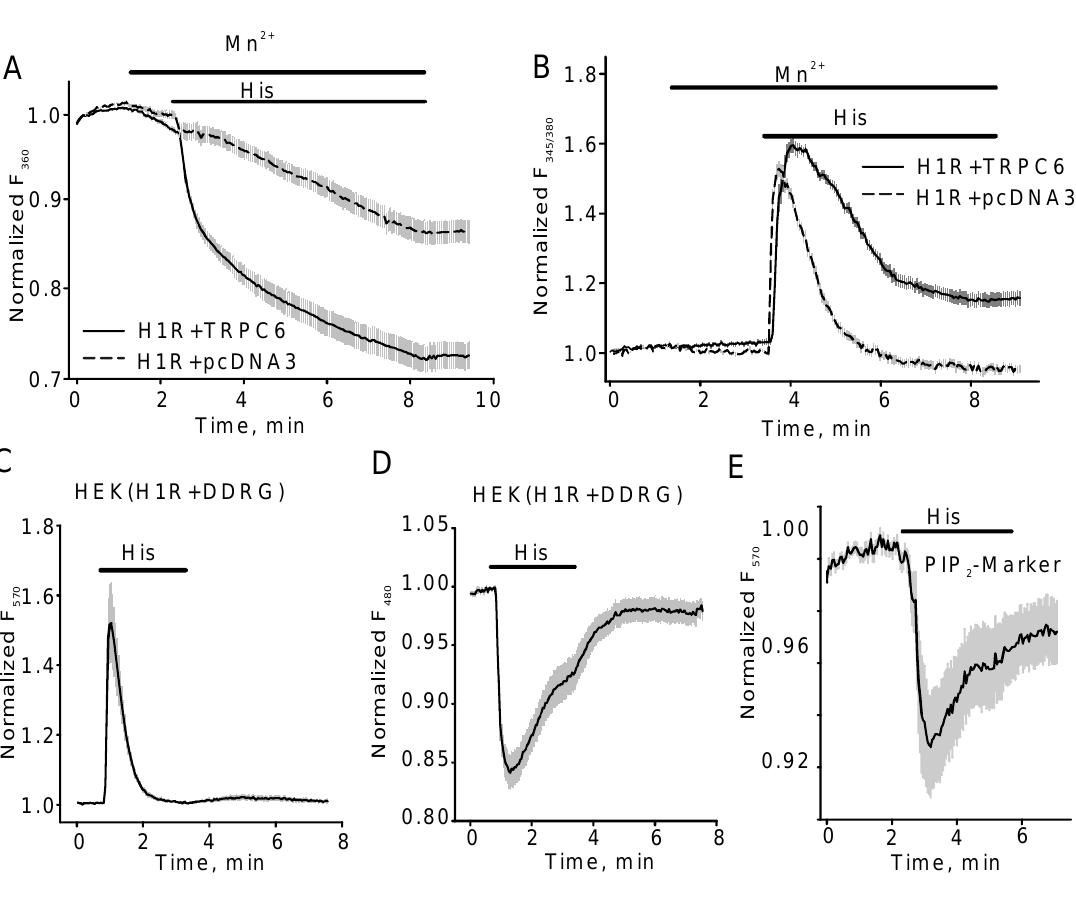
Figure 1. Histamine induces transient intracellular diacylglycerol (DAG), phosphatidylinositol diphosphate (PIP ) and Ca 2+ increases in histamine H1 receptor (H1R)- 2 expressing human embryonic kidney (HEK) cells. ( A , B ) The traces show fluorescence changes in HEK cells expressing H1R + pcDNA3 or H1R + TRPC6. Mn 2+ (0.5 mM) influx was determined in the control group and cells expressing TRPC6 channel using the Mn 2+ quench approach. Fura-2 fluorescence was excited at 360 nm and the percent of fura-2 fluorescence decrease was shown in ( A ). ( B ) shows fluorescence intensity ratios (F /F ) 345 380 acquired during the same experiment. The fluorescence was normalized to the baseline fluorescence. To detect intracellular Ca 2+ transients, the downward DAG+R-GECO sensor (DAG/Ca 2+ R) was excited at 570 nm, whereas DAG transients were assessed when DAG+R-GECO sensor fluorescence was excited at 480 nm ( C , D ). ( E ) shows the averaged trace ( n = 12) of PIP level changes in the presence of histamine in HEK cells co- 2 expressing the red fluorescent PIP sensor and 2